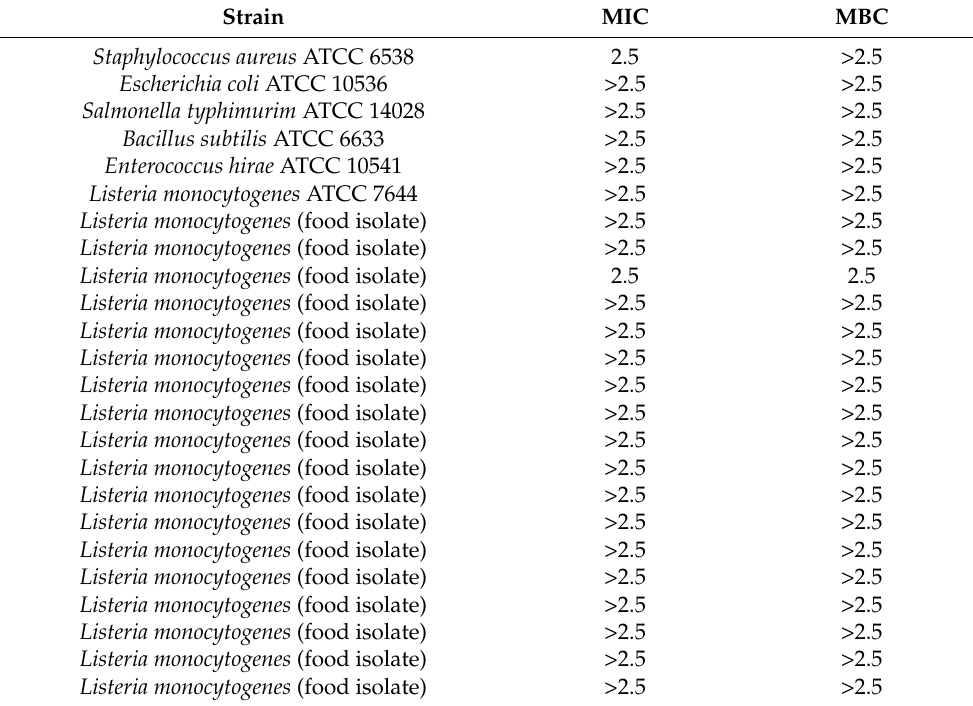
Table 2. MICs and MBCs of H.s. extract (expressed as mg mL − 1 ) against Gram-positive bacteria and Gram-negative